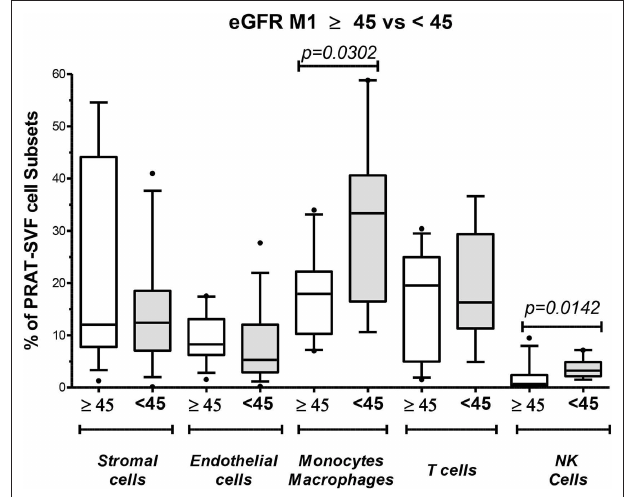
FIGURE 6 | Analysis of perirenal adipose tissue stromal vascular fraction (PRAT-SVF) with lower recovery of graft persisting at M1 post-transplant. Donors were split into two groups according to graft recovery persisting at M1 post-transplant: lower recovery (eGFR M1 < 45) and normal recovery (eGFR > 45). The proportion of cell subsets was analyzed according to this splitting. The eGFR M1 < 45 presented a significantly higher percentage of monocyte/macrophage subset and NK cells. Other cells were similarly distributed between the two